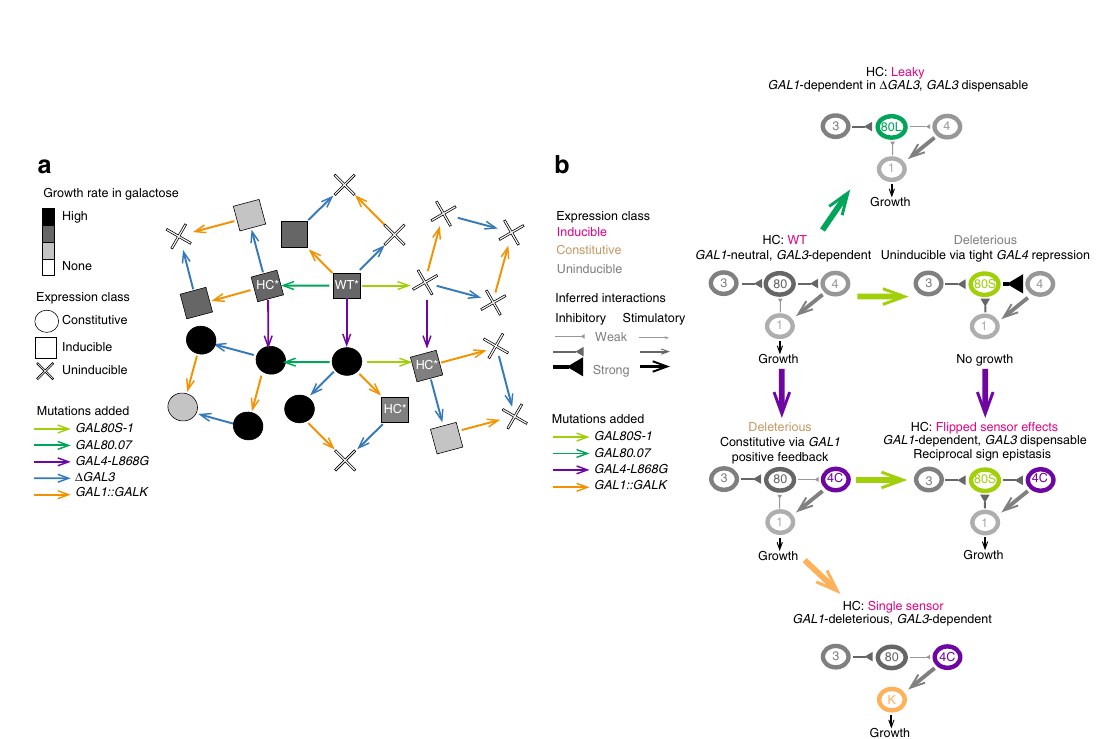
Fig. 4 Rewiring of regulatory networks in harmonious genetic combinations. a Snow fl ake fi tness landscape showing the dependency of GAL4-GAL80 genotype pairings on GAL1 and GAL3 sensor activity. The shape of each node indicates expression phenotype and shading the growth rate in galactose. While many “ harmonious ” combinations of WT-like phenotypes are present, we highlight particular combinations to illustrate where galactose sensing requirements have changed appreciably (HC*). While all harmonious combinations require some combination of GAL1 or GAL3 for growth and expression in galactose, the dependence on GAL3 and GAL1 varies across every GAL4-GAL80 background. b Rewiring of the GALR network across harmonious combinations. Each network ’ s inferred wiring is illustrated for a given allelic combination, including Leaky GAL80 . 07 ( “ 80L ” ), super-repressor GAL80S-1 ( “ 80s ” ), the GAL1 sensor deletion construct GAL1 :: GALK ( “ K ” ), and Constitutive GAL4-L868G ( “ 4C ” ). “ Inducible ” classes include Leaky phenotypes, which show low but detectable expression levels in glucose and high expression in